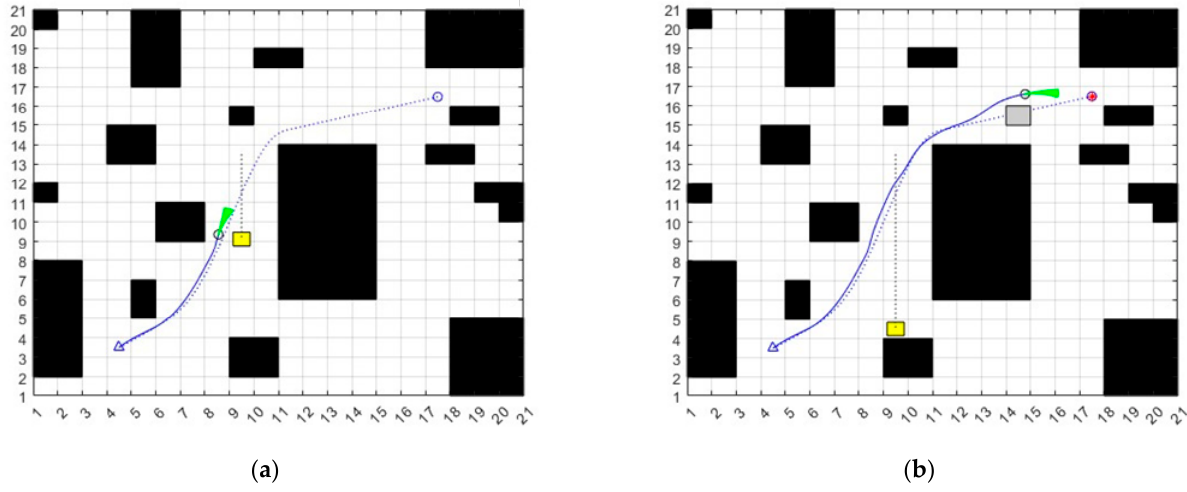
8. In the fi gure, the black squares are obstacles. The black do tt ed line is the path. The tri- angle with coordinates (4, 3) is the starting point. The coordinate (17, 16) is the end point. Figure 8. ( a ) Traditional A* path, ( b ) B spline smooth path. In the map, the black squares are obstacles. The triangle is the starting point, the circle is the goal point. The circle with the green arc is the mobile robot. The yellow square is the moving obstacle, the gray square is the temporary static obstacle. The blue dashed line is the global path, and the blue solid line is the fi nal generated path. To verify the global path planning and the ability to avoid local dynamic obstacles of the improved A* fusion DWA algorithm, a 21 m × 21 m raster map is selected for the experiment. A movable ob- stacle is set in the path of the robot. The simulation experiment results are shown in Figure 9.